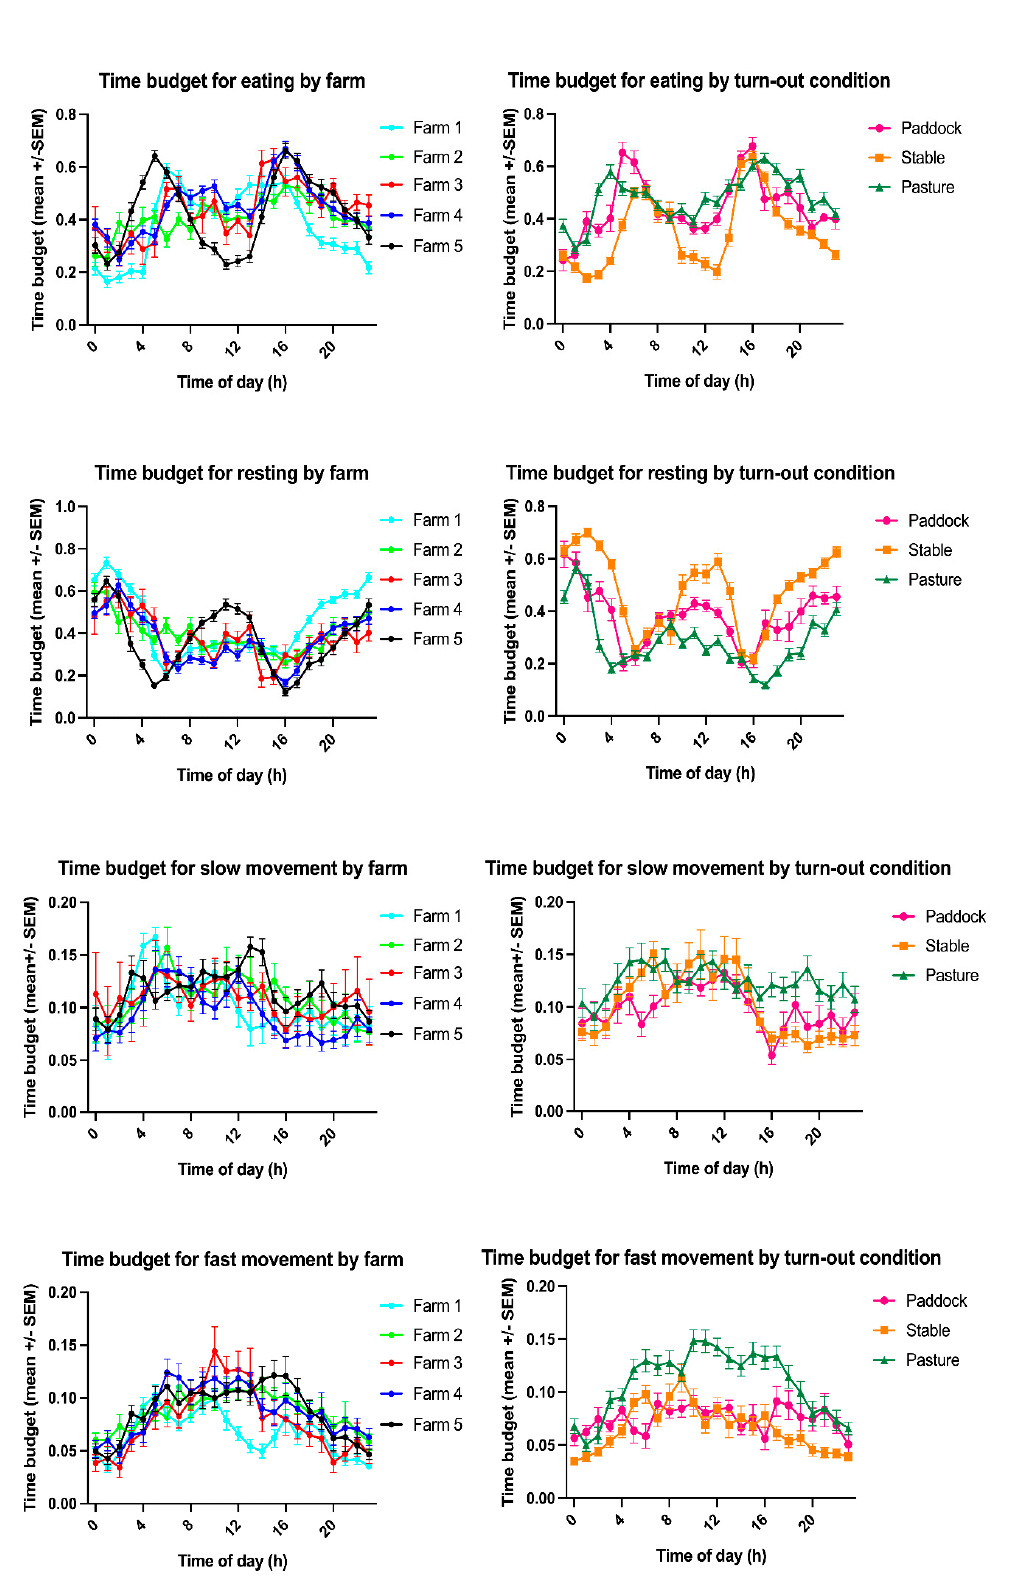
Figure 2. Time budgets for eating, resting, slow movement (“active”) and fast movement (“highly active”) by farm ( left ) and by turn-out condition ( right ) detailed by time of day.